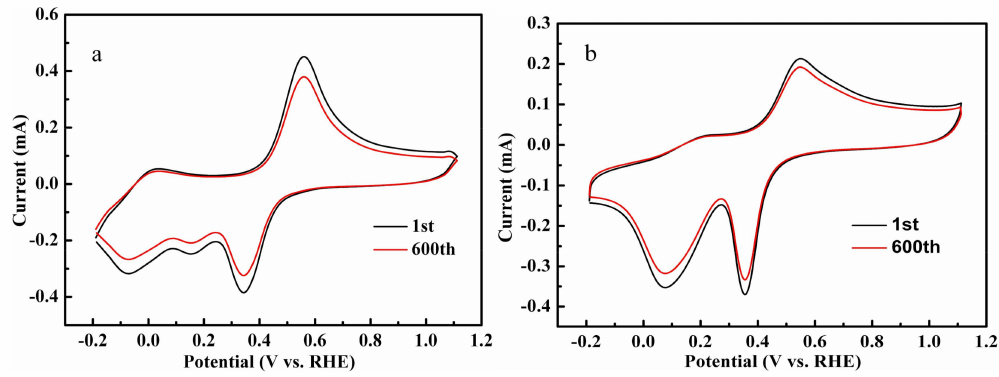
Figure 14. Continuous cyclic voltammetry (CV) measurements of Complex 1 /C ( a ) and Complex 2 /C ( b ) in PBS saturated with O 2 , Scan rate: 100